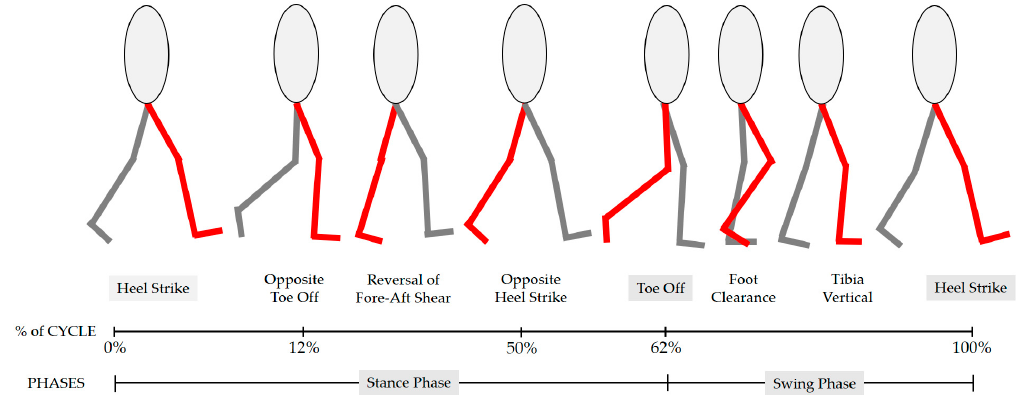
Figure 2. The gait cycle is divided into the stance phase and swing phase.